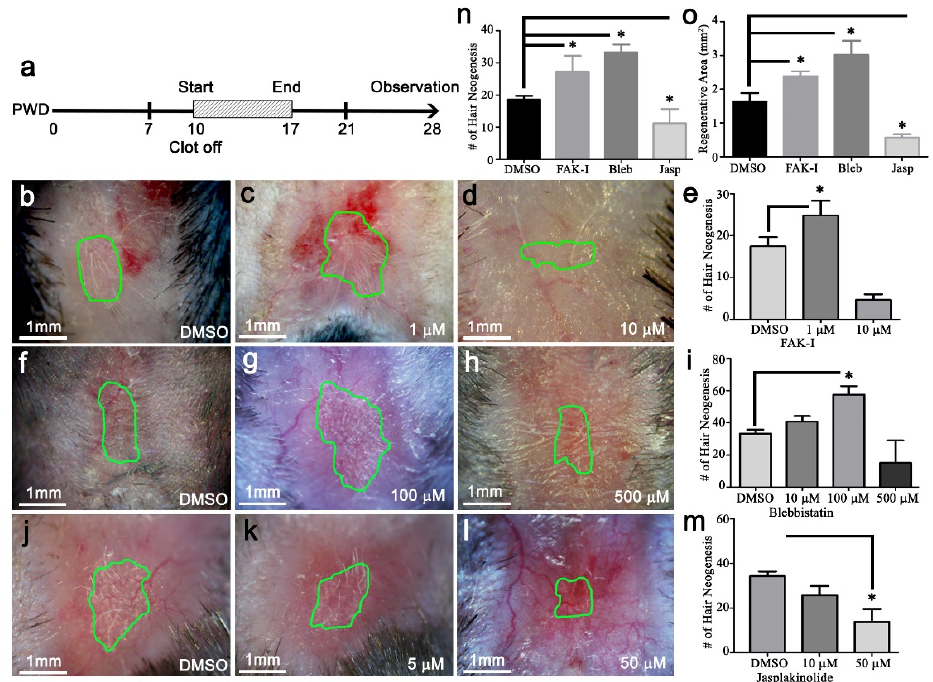
Figure 5. Perturbing the wound bed mechanical microenvironment modulated wound-induced hair follicle neogenesis. ( a ) Timeline of dose-response treatment experiments. ( b – e ) Topical treatment with FAK inhibitor PF573288 or ( f – i ) myosin II inhibitor blebbistatin increased WIHN and the total regenerative area at PWD 28. ( j – m ) Topical treatment with actin cytoskeleton stabilizer jasplakinolide treatment reduced WIHN and the total regenerative area at PWD 28. ( n ) Hair neogenesis and ( o ) regenerative area quantification after mechanotransduction perturbation treatments (green line; regeneration area outline, scale bar; 1 mm, ( n = 4), data are represented as mean ± SEM, * p <